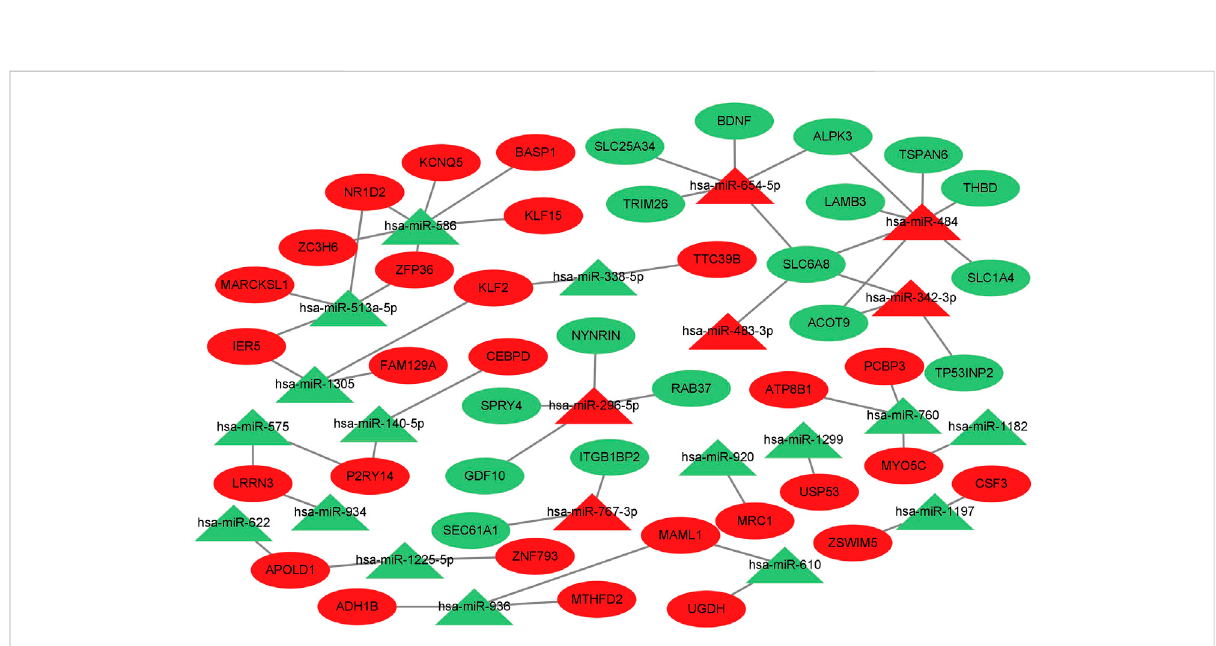
FIGURE 5 Prediction of target genes for differentially expressed miRNAs and construction of a miRNA ‒ mRNA gene regulatory network. miRNA ‒ mRNA generegulatorynetwork. miRNAsare shownas triangles, andtarget genesareshown asovals.Redindicates upregulated genes,and greenindicates downregulated